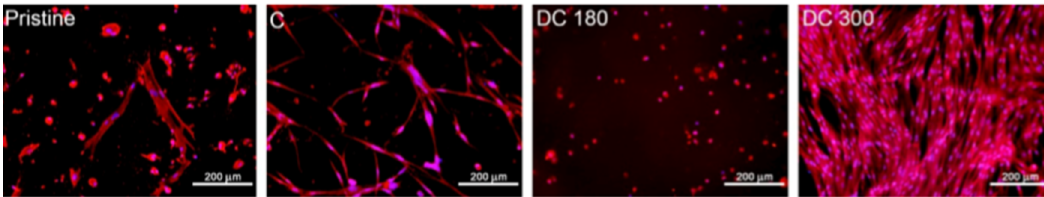
Figure 6. Digital images of human dermal fibroblasts cultured on bacterial cellulose after seven days of cell seeding in pristine incorporated with curcumin (C) degraded at 180 °C (DC 180 °C), and 300 °C (DC 300 °C). The cells shown were stained with Texas Red C2-Maleimide (red fluorescence, cell membrane and cytoplasm) and Hoechst #33258 (blue fluorescence, cell nuclei). (Adapted from